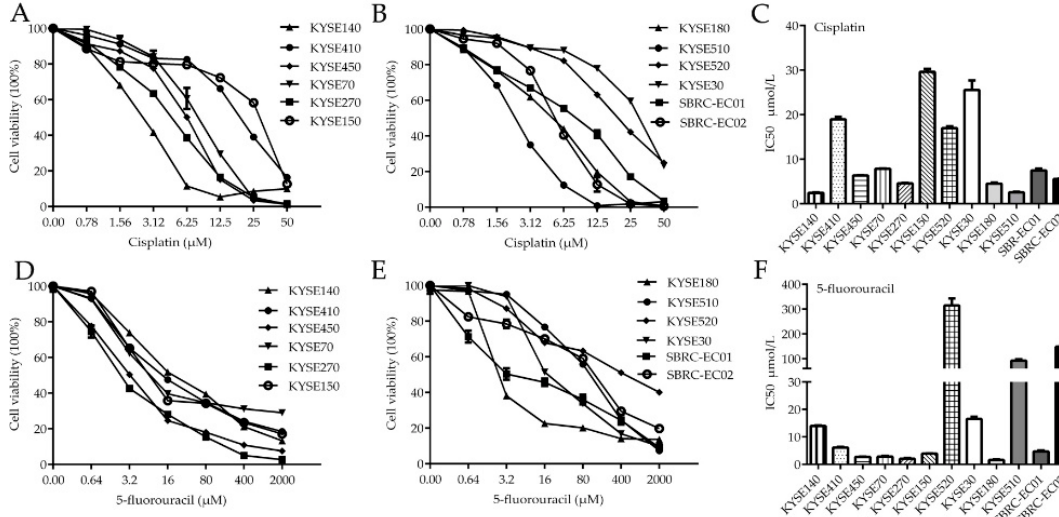
Figure 2. Cell Viability assays display the effect of 5-fluorouracil and cisplatin in ESCC cell lines and two patient-derived tumor cells. ( A – C ) Cytotoxicity assay of cisplatin in ESCC cell lines and two patient-derived tumor cells. ( D – F ) Cytotoxicity assay of 5-fluorouracil in ESCC cell lines and two patient-derived tumor cells. Patient-derived tumor cells include SBRC-EC01 and SBRC-EC02. Tumor cells were treated with increasing concentrations of drugs for 72 h. Cell viability was measured using MTS assay, and IC50 value (half maximal inhibitory concentration) was calculated. Data are shown as the mean ± SD of 3 independent experiments.